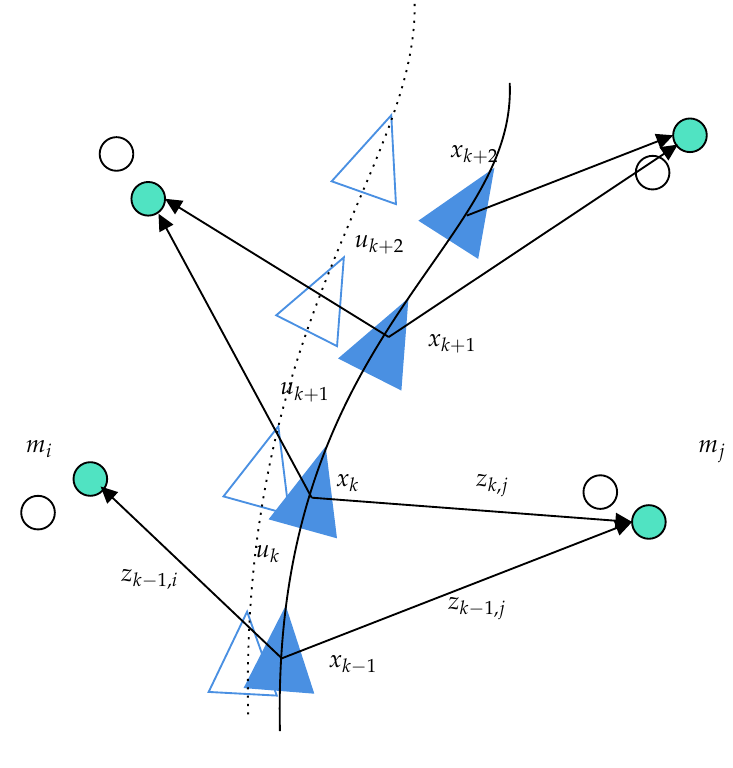
Figure 2. SLAM process illustration and notations. In blue, the estimated trajectory and map; in white, the ground